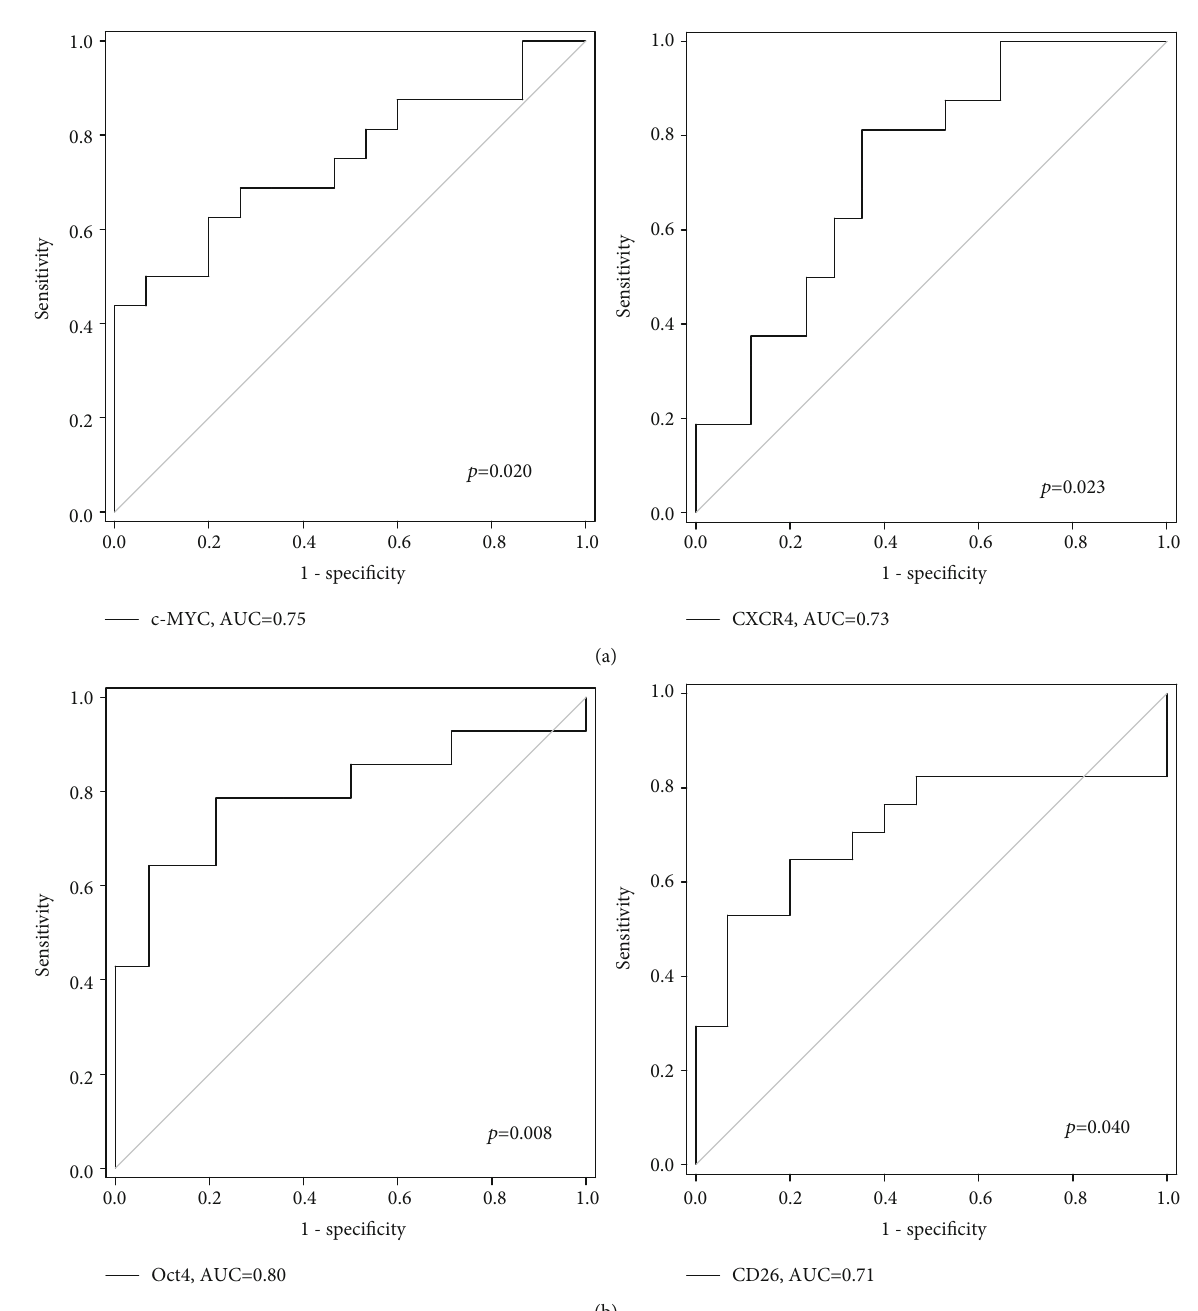
Figure 3: ROC analyses showing that (a) c-MYC and CXCR4 can identify polyp from normal patients and (b) Oct4 and CD26 can identify CRC from polyp